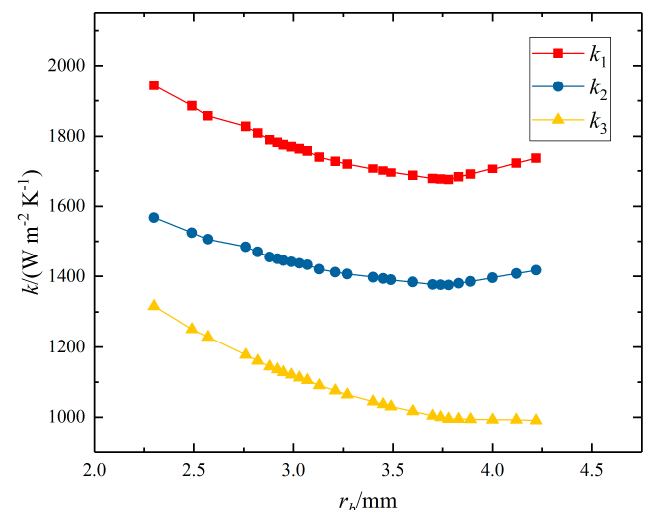
Figure 12. Overall heat transfer coefficients of heat exchangers under different r b .